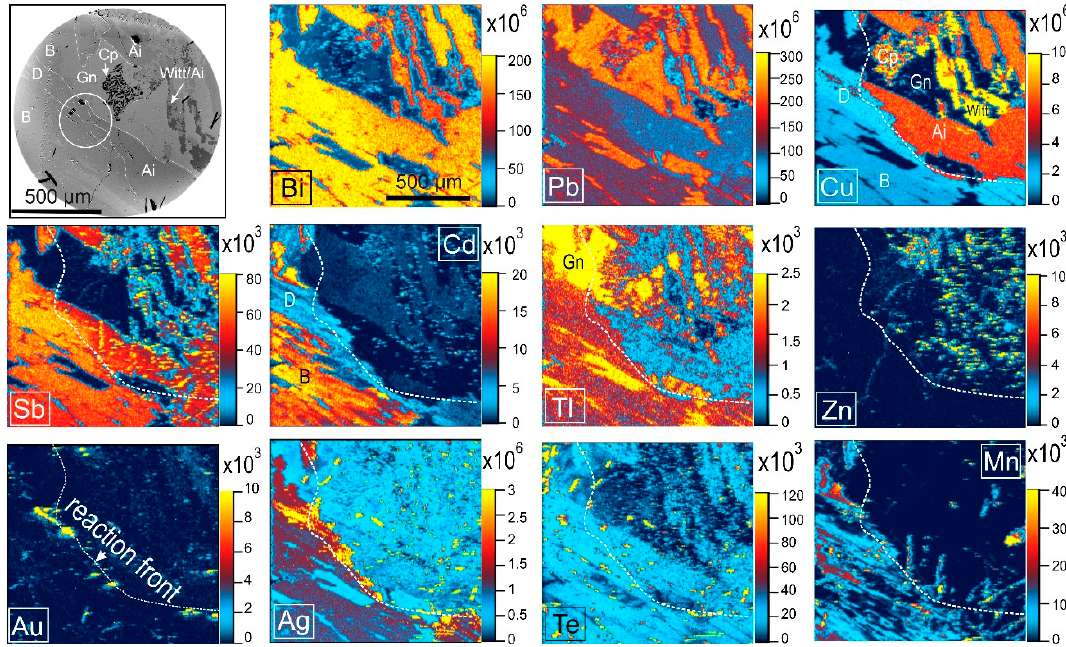
Figure 4. Secondary Electron (SE) image showing the mapped areas ( top left ). Circle: area of FIB cuts (see Figure 5b) and LA-ICP-MS element maps for an area along the ‘reaction front’ marked on Figure 2a. See text for more explanations. Ai–aikinite; B–bright Pb-Bi-sulphosalt; D–dark Pb-Bi-sulphosalt; Cp–chalcopyrite; Gn–galena; Witt–wittichenite.